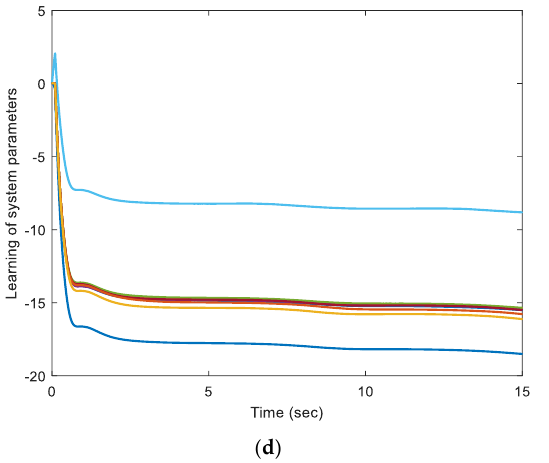
Figure 4. Responses of Figure 3 case with the proposed ARM-FTC. ( a ) Trajectory − tracking. ( b ) Norm of nonlinear auxiliary sliding surfaces. ( c ) Control inputs. ( d ) Learning parameters.